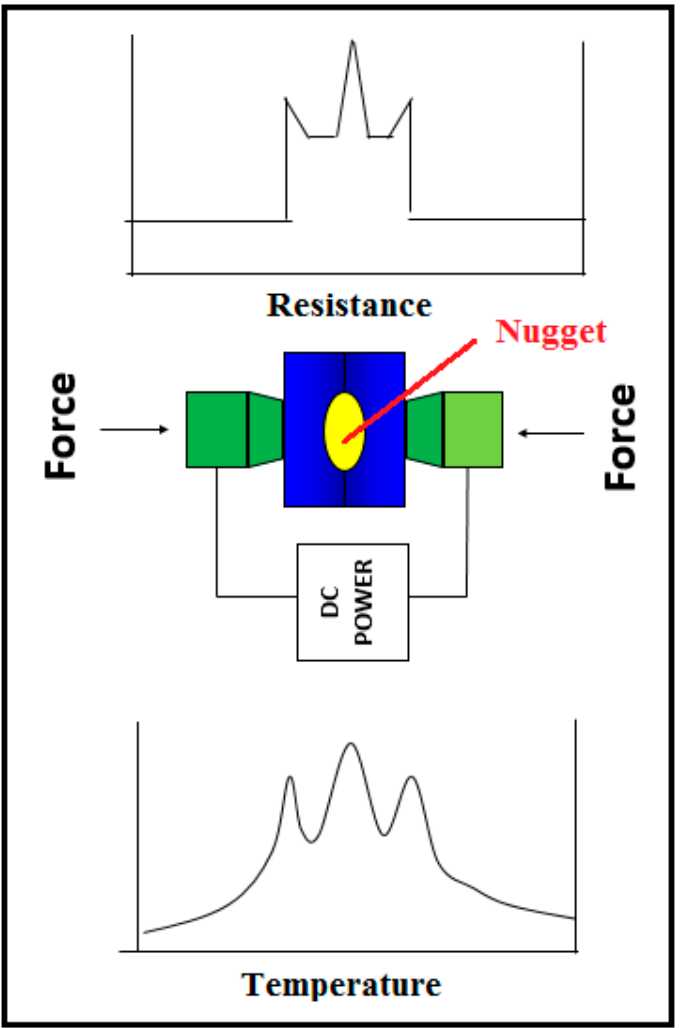
Figure 7. Resistance and temperature distributions of electrode and steel sheets.